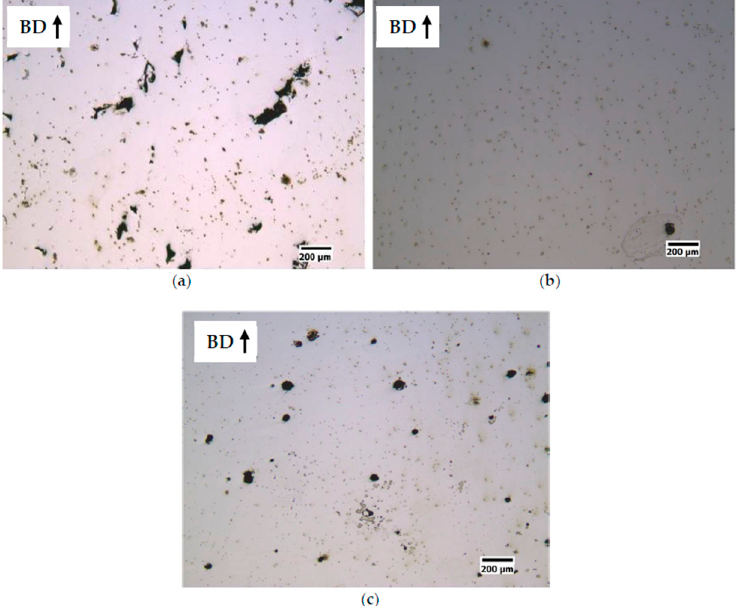
Figure 6. Effect of the specific laser energy E [Jm -1 ] on the densification of FeSi3 steel samples. ( a ) sample S1 (E = 150 Jm − 1 , v = 0.5 ms − 1 , P = 75 W), relative density of the sample 99.93% and pores with irregular shape; ( b ) sample S7 (E = 250 Jm − 1 , v = 1 ms − 1 , P = 250 W), relative density of the sample 99.99%; ( c ) sample S18 (E = 350 Jm − 1 , v = 0.5 ms − 1 , P = 175 W), relative density of the sample 99.98% and pores with spherical shape.